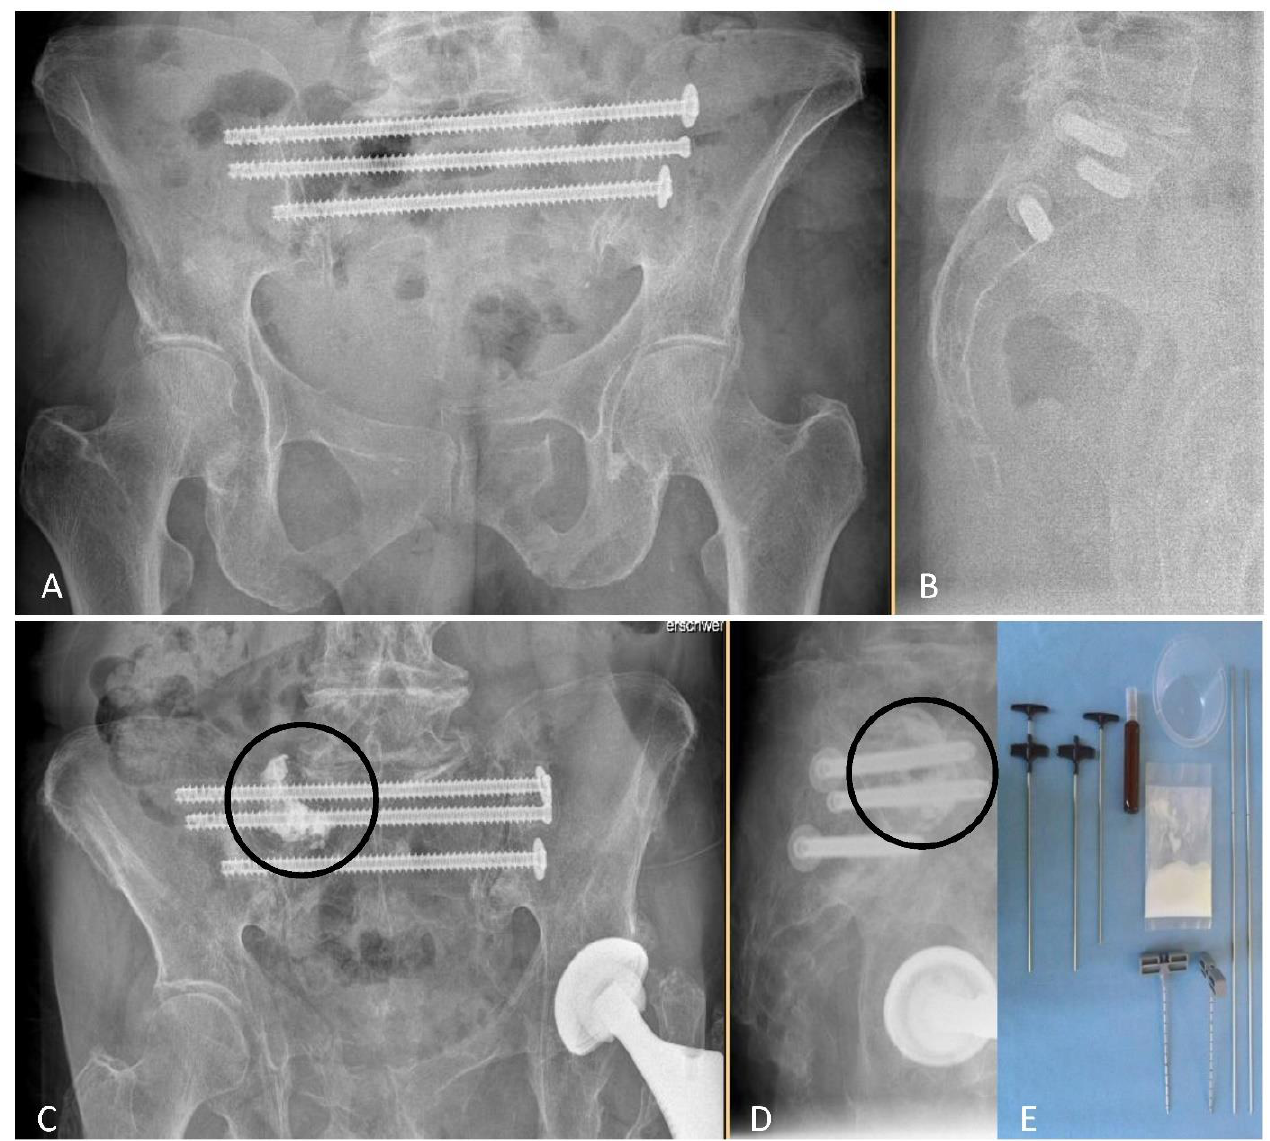
Figure 1. Post-surgical radiographs (anteroposterior ( A , C ) and lateral views ( B , D ) in standing position) after NSF ( A , B ), or NSF + ASP (( C , D ), cement location indicated by circles). Required disposable materials for an ASP procedure are shown in ( E ). NSF indicates navigation-assisted screw fixation; ASP, additional sacroplasty.